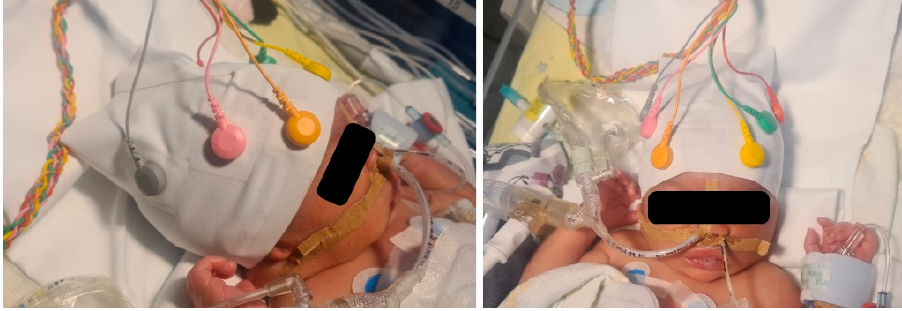
Figure 4. The EEG cap prototype with electrode connections.